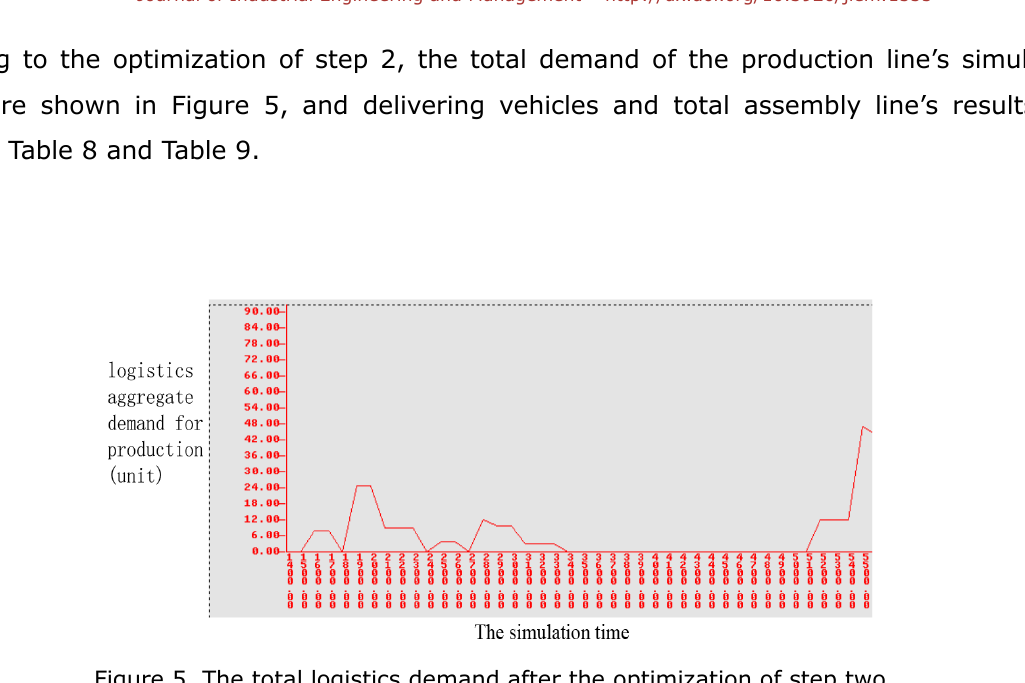
Figure 5. The total logistics demand after the optimization of step two